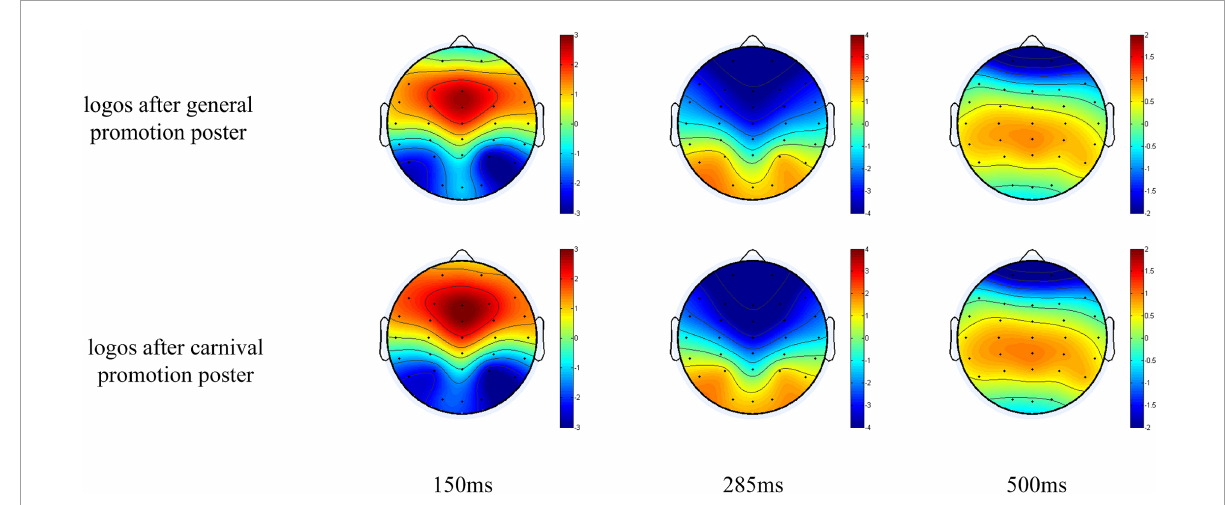
FIGURE3 Topographic maps of the voltage field topography at the peak of the P2, N2, and P3 evoked by logos after general and carnival promotion poster. Red and yellow are positive, blue and black negative, scaled from –3 to 3 mV (P1), –4 to 4 mV (N2), and –2 to 2 mV (P3).